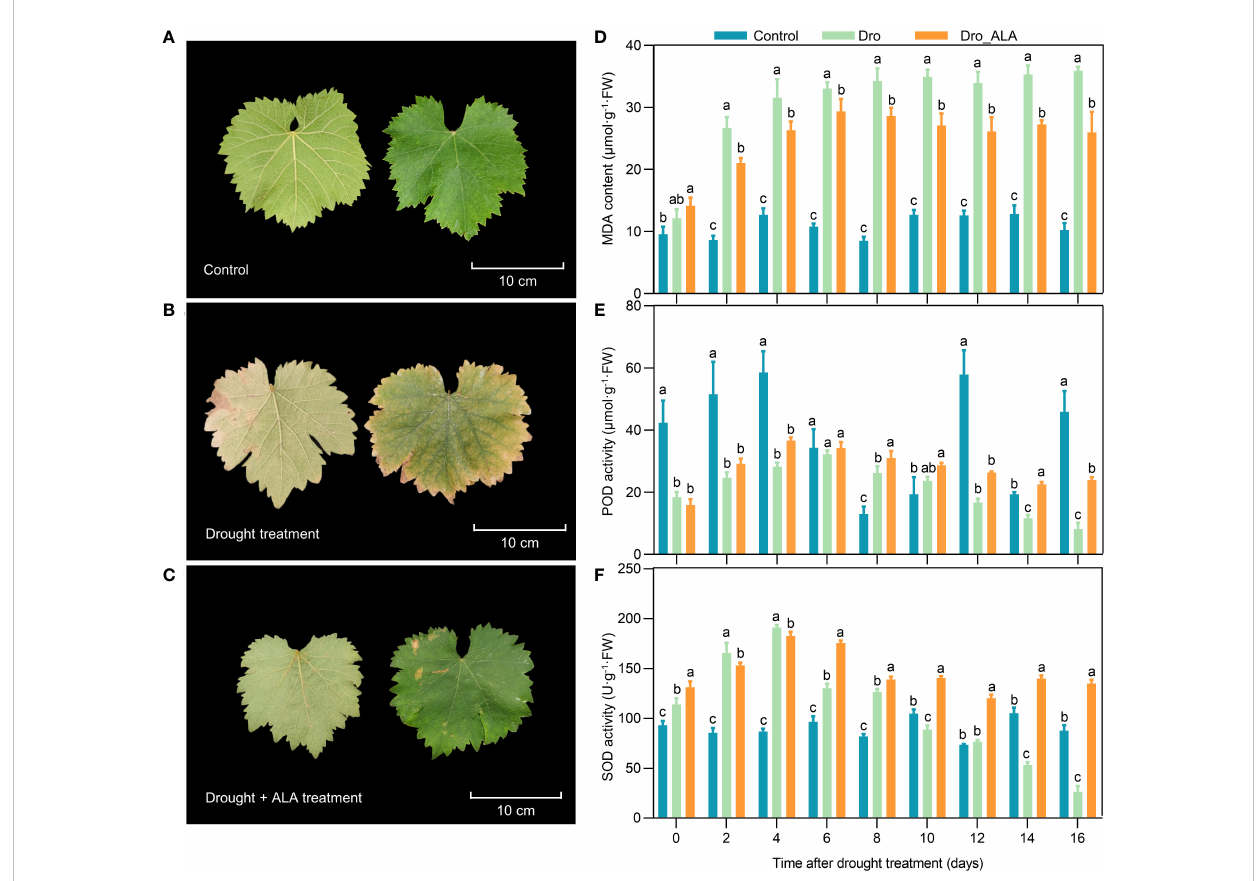
FIGURE 1 Leaf phenotype observation and physiological index determination (A) Leaf phenotype of control on the 16 th day. (B) Leaf phenotype of drought treatment (Dro) on the 16 th day. (C) Leaf phenotype of drought plus 5-aminolevulinic acid treatment (Dro_ALA) on the 16 th day. (D) Malondialdehyde (MDA) content changes with time under control, Dro and Dro_ALA groups. (E) Peroxidase (POD) activity changes with time under control, Dro and Dro_ALA groups. (F) Superoxide dismutase (SOD) activity changes with time under control, Dro and Dro_ALA groups. In Figure 1C, the left side of each picture shows the bottom surface of the leaf, and the right side shows the top side of the leaf. Different letters in a column indicate signi fi cance of difference between treatments (P ≤